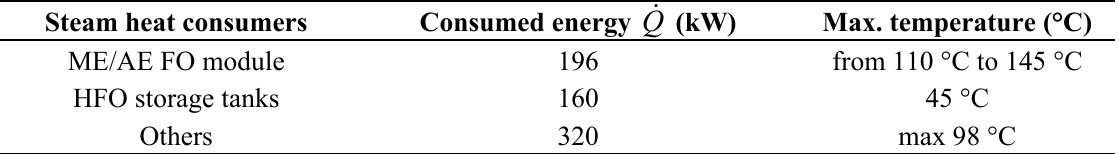
Table 1. Heat consumption during navigation for fuel, lube oil and hot water heating.